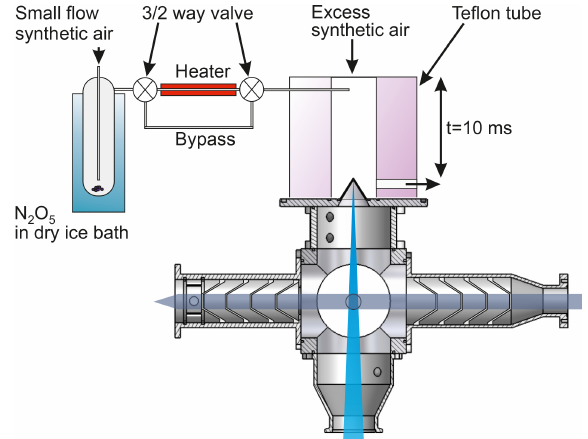
Figure 3. Set-up for laboratory experiments testing NO 3 / N 2 O 5 . Frozen N 2 O 5 is over flowed by nitrogen. The source can be switched to an NO 3 source if N 2 O 5 is thermally decomposed in a heater. This flow is injected into a large flow of synthetic air pro- vided by the radical source that is mounted on top of the Teflon tube (not shown here, see Fig. 2). Only a small part is sampled by the in- strument. The cell with the short inlet is shown, but the set-up was the same for the cell with the long